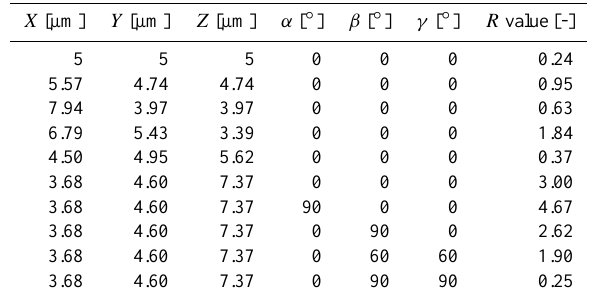
Table 2. The ellipsoids used as examples of how the non- sphericity influences the light-scattering calculations and with that the R value. X , Y and Z are the double lengths of the semi-axes; α , β and γ define the orientation of the particles, in terms of how much the axes attached to the particle are rotated, first by α over the z axis, then by β over the y axis and lastly by γ over z (cid:48) , the new position of the z axis. The propagation of the incident light is along the z